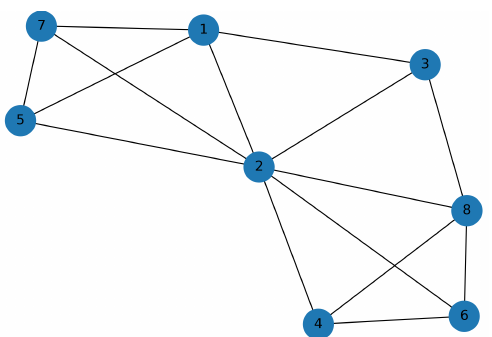
Figure 10. Clustering graph G ( V , E ) for δ =